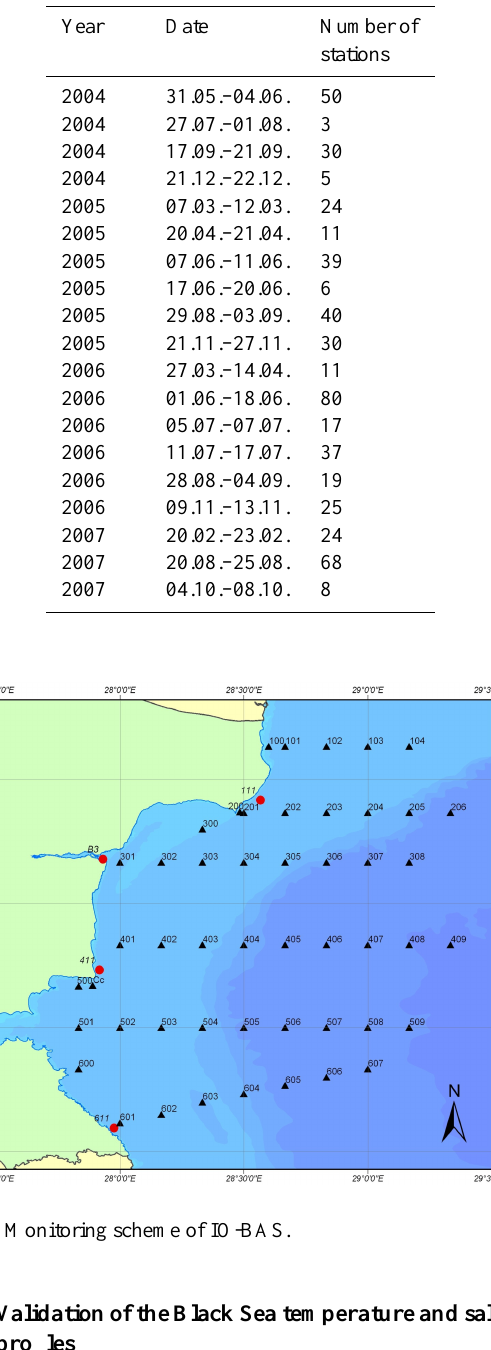
Table 3. Duration and number of sampled stations presented in the IO-BAS database.